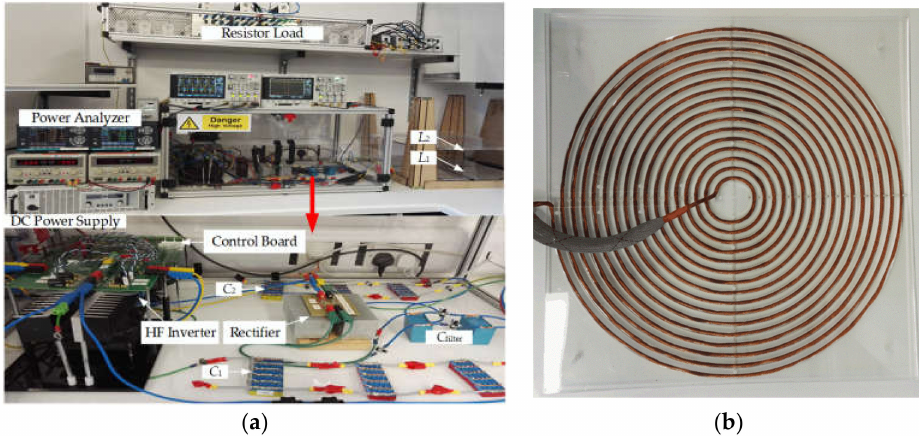
Figure 5. Experimental Platform of the WPT System: ( a ) Whole system; ( b ) Practical coil with 16 turns, 30 mm inner radius and 10 mm channel